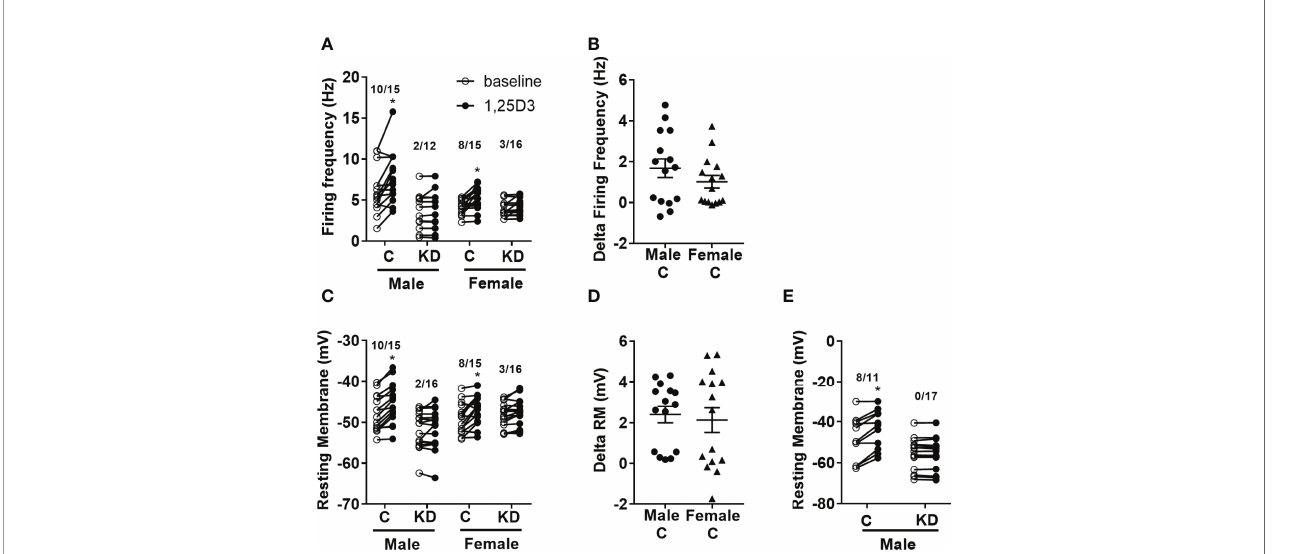
FIGURE 4 | Vitamin D activates PVH neurons through the VDR. (A) Firing frequency response to 1,25D 3 treatment in male and female control VDR +/+;Sim1-cre;TOMATO ( “ C ” ) and PVH VDR knockdown VDR f/f;Sim1-cre;TOMATO ( “ KD ” ) mice. (B) Firing frequency change after 1,25D 3 in male and female control mice. (C) Resting membrane potential response to 1,25D 3 treatment. (D) Resting membrane change after 1,25D 3 in male and female control mice. (E) Resting membrane potential response to 1,25D 3 treatment in male mice in the presence of synaptic blockers (TTX, DAP-IV, CNQX, and bicuculine). *p < 0.01 compared to untreated state. N=11-18 neurons/